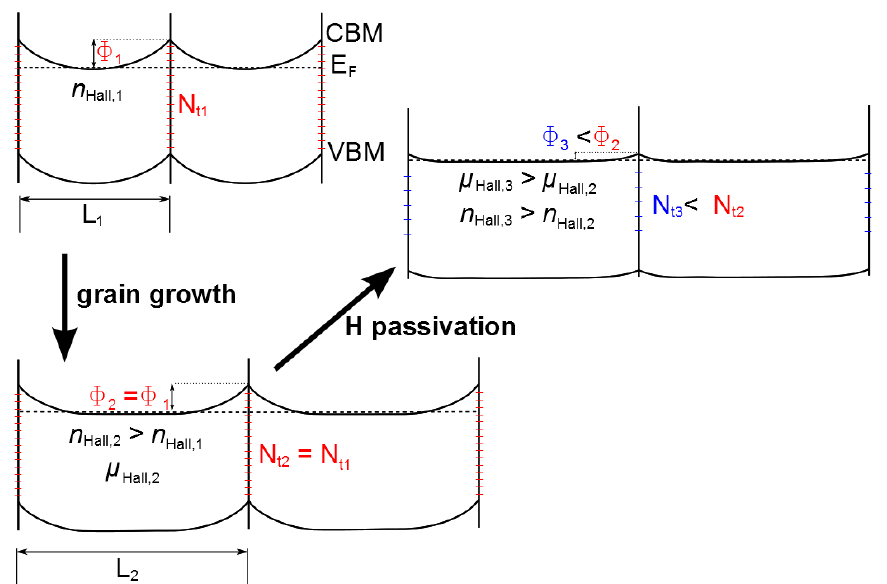
Figure 7. Schematic model of two neighboring grains with grain size L in order to elucidate the influence of grain growth on carrier concentration and the dependence of grain boundary states (N ) on transport barriers ( φ ) for electron t